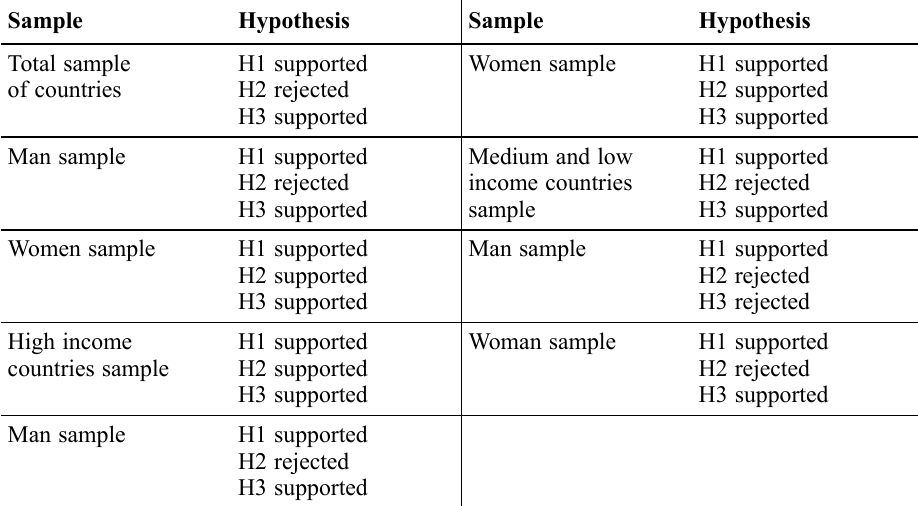
Table 7. Hypotheses